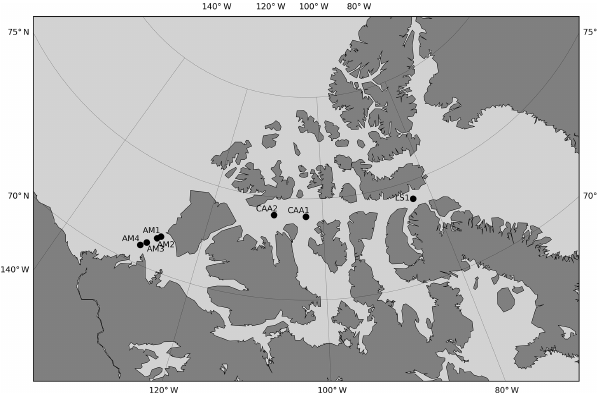
Figure 9. Location of the stations visited over an interval of 5 years or more. Stations are designated by area-related acronyms (LS is Lancaster Sound, CAA is Canadian Arctic Archipelago, AM is Amundsen Gulf) that are not the station identifiers used during the